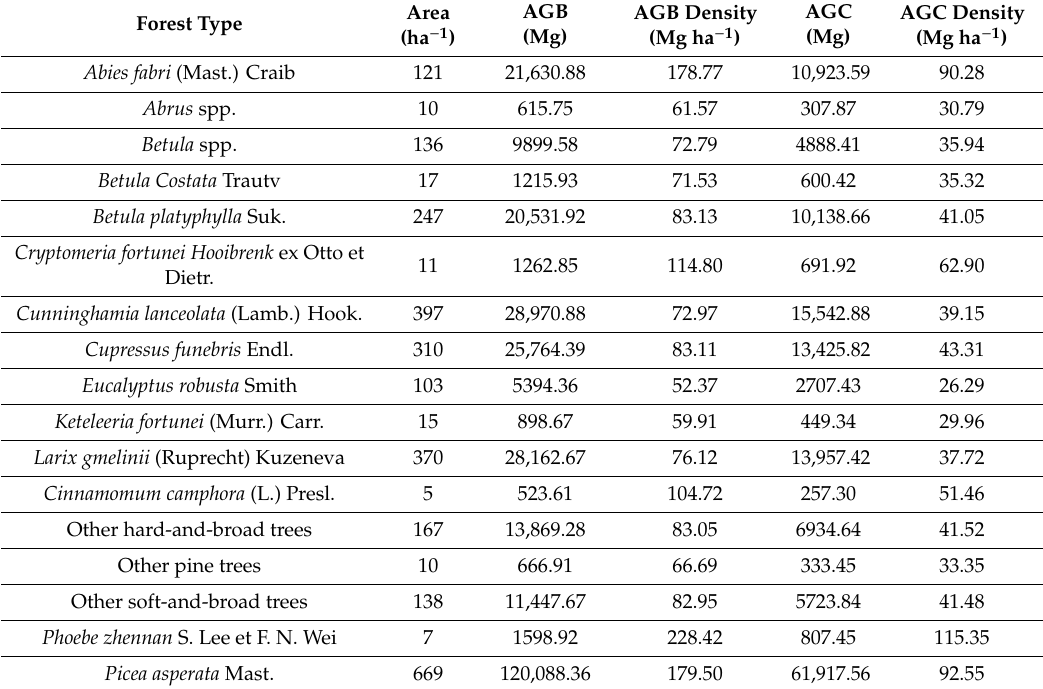
Table 8. Aboveground biomass (AGB), AGB density, aboveground carbon (AGC) and AGC density of each forest type.